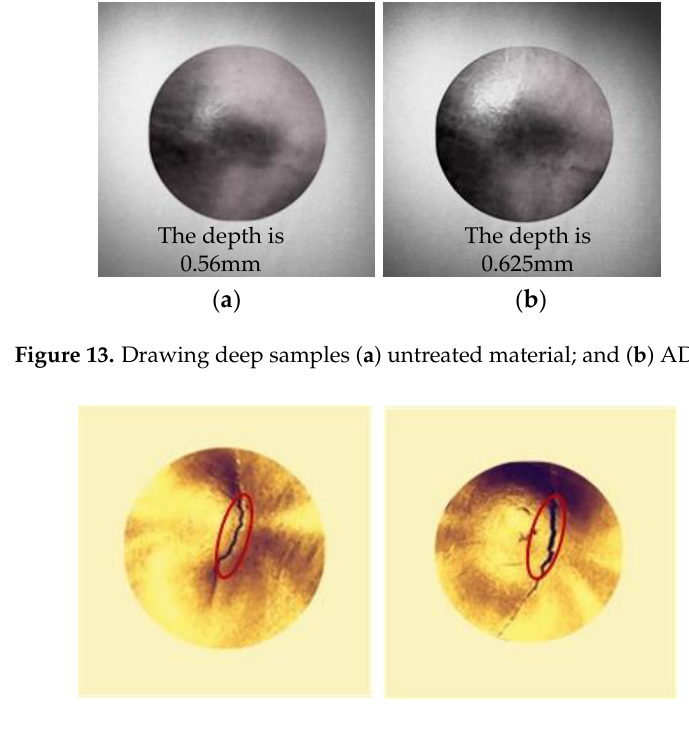
Figure 12. Results of deep drawing tests: ( a ) averaged limit depth; and ( b ) averaged load.